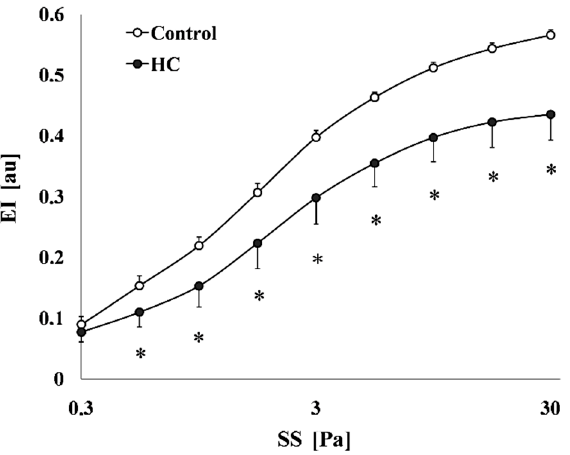
Figure 4. The red blood cell deformability describing elongation index (EI [au]) in the function of shear stress (SS [Pa]) of the Control and the atherogenic groups (HC); Means ± SEM; * p < 0.05 vs. Control.